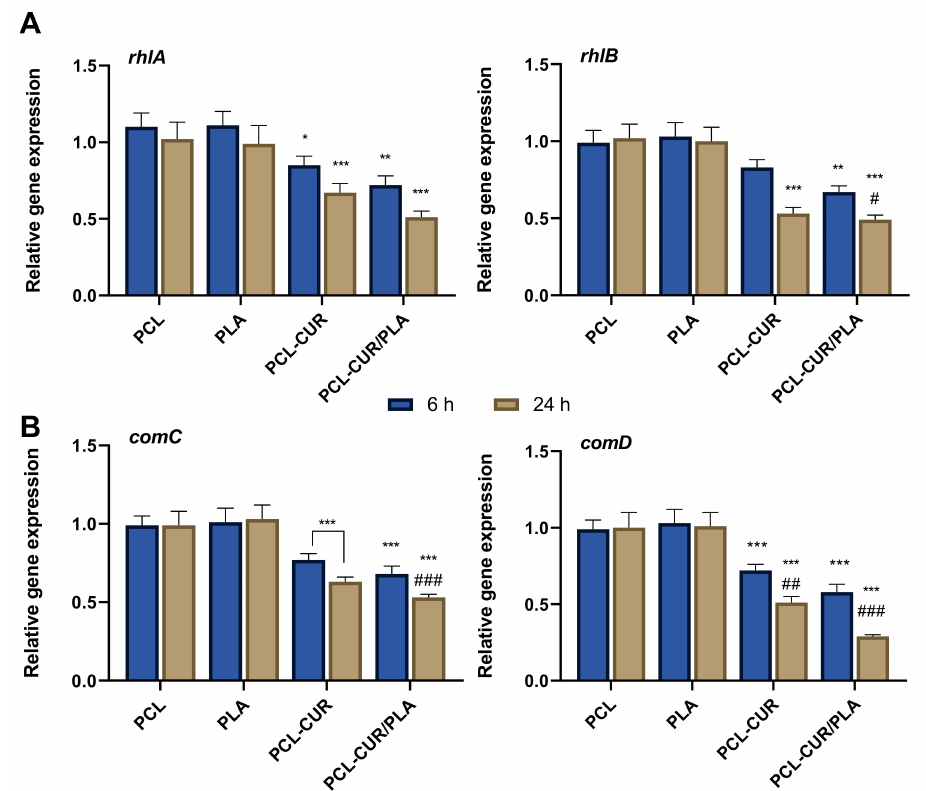
Figure 6. Evaluation of the effect of the CUR-loaded membranes on the expression of QS-related genes. ( A ) Relative RNA expression of rhlA and rhlB in PAO1; ( B ) relative RNA expression of comC and comD in S. mutans . Different gene expression levels were normalized to the level of 16sRNA gene transcripts. Gene expression levels of biofilm formed in the presence of PCL were used as control. Statistically significant variations: * p < 0.05 versus PCL and PLA; ** p < 0.01 versus PCL and PLA; *** p < 0.001 versus PCL and PLA; # p < 0.05 versus PCL-CUR; ## p < 0.01 versus PCL-CUR; ### p < 0.001 versus PCL-CUR.